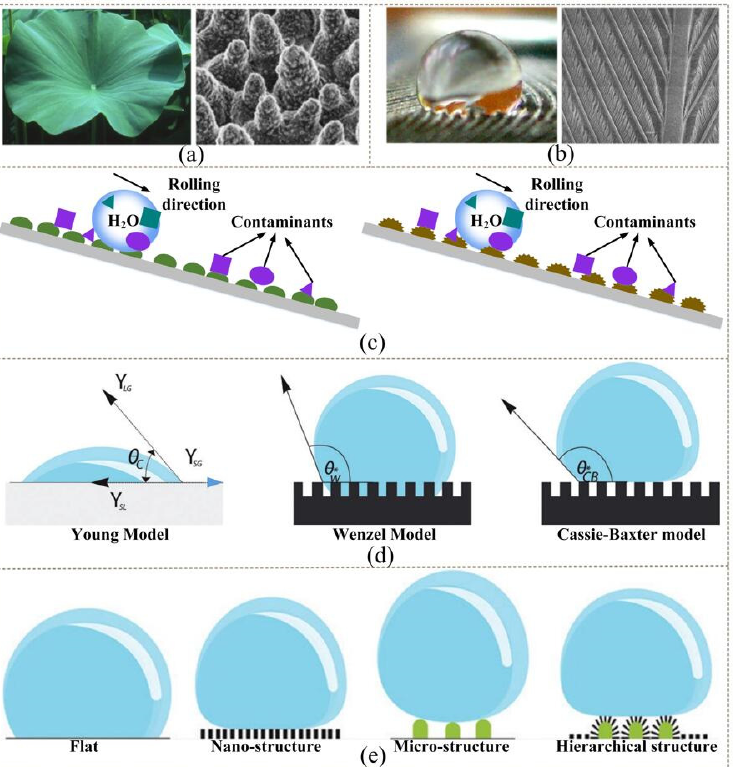
Figure 1. Typical hydrophobic mechanisms of superhydrophobic surfaces in nature: ( a ) SEM images of lotus leaf surfaces [34]; ( b ) SEM images of bird feather surfaces [35]; ( c ) self-cleaning mechanism of superhydrophobic surface [36]; ( d ) liquid droplet on solid surfaces, representing the Young, Wenzel, and Cassie–Baxter models [37]; ( e ) different types of surface roughness and wettability [38].